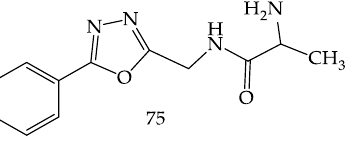
Figure 19. The 2-amino-N-((5-phenyl-1,3,4-oxadiazol-2-yl) methyl) propanamide as HDAC inhibi- tor .